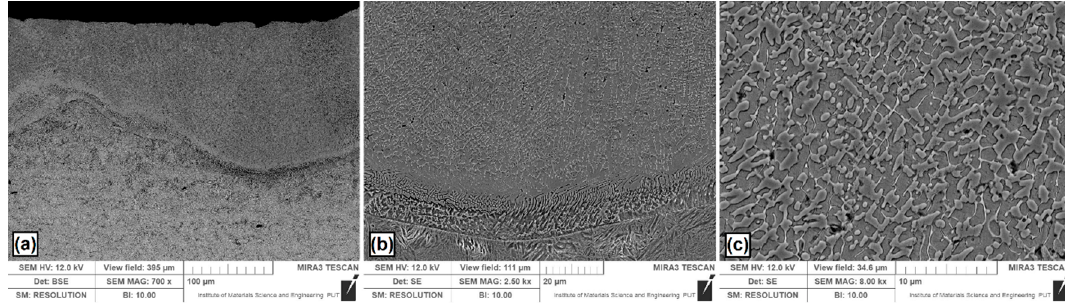
Figure 4. Microstructure of boron coating produced using laser alloying: ( a ) laser tracks; ( b ) boundary between the MZ and HAZ; ( c ) magnification of selected area in the MZ.